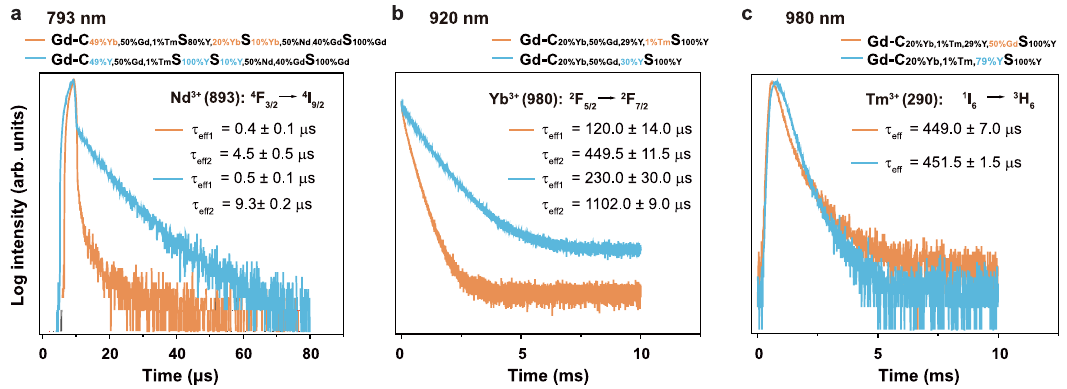
Fig. 4 Lifetime measurements to quantify the step-wise energy transfer ef fi ciencies of from Nd 3 + to Yb 3 + , from Yb 3 + to Tm 3 + and from Tm 3 + to Gd 3 + ion. a Luminescence decay curves of Nd 3 + emissions measured at 893 nm for NaGdF 4 :49%Yb,1%Tm@NaYF 4 :20%Yb@NaGdF 4 :10%Yb,50%Nd@NaGdF 4 (with Yb 3 + ) and NaGdF 4 :49%Y,1%Tm@NaYF 4 @NaGdF 4 :10%Y,50%Nd@NaGdF 4 (without Yb 3 + ) by pulsed 793 nm excitation. b Luminescence decay curves of Yb 3 + emissions measured at 980 nm for NaGdF 4 :20%Yb,1%Tm,29%Y@NaYF 4 (with Tm 3 + ) and NaGdF 4 : 20%Yb,30%Y@NaYF 4 (without Tm 3 + ) by pulsed 920 nm excitation. c Luminescence decay curves of Tm 3 + emissions measured at 290 nm for NaGdF 4 :20%Yb,1%Tm,29%Y@NaYF 4 (with